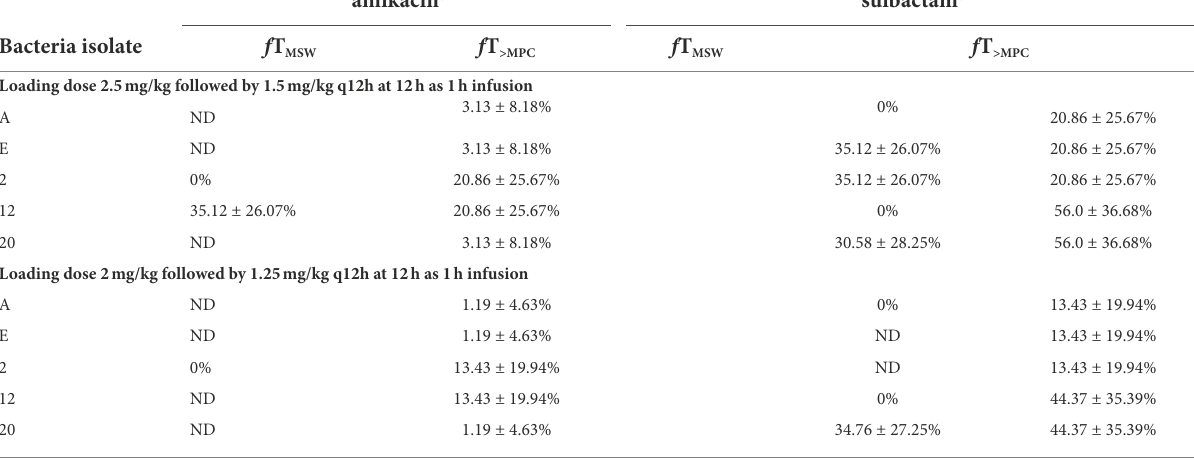
‡ See Table 1 for list of dosing regimens by renal function category; simulations were based on assumption of 90% PTA achieved in the plasma using amikacin/sulbactam dosing regimens of 20 mg/kg/day q24h/3 g q8h as 3 h infusion in CL CR > 50 to 150